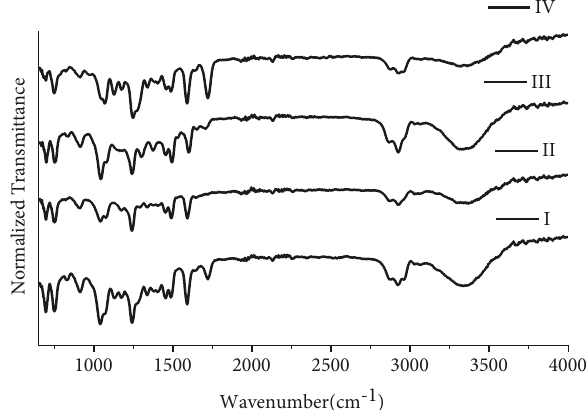
Figure 7: FTIR spectra for groups I, II, III, and IV of red ballpoint pen inks.